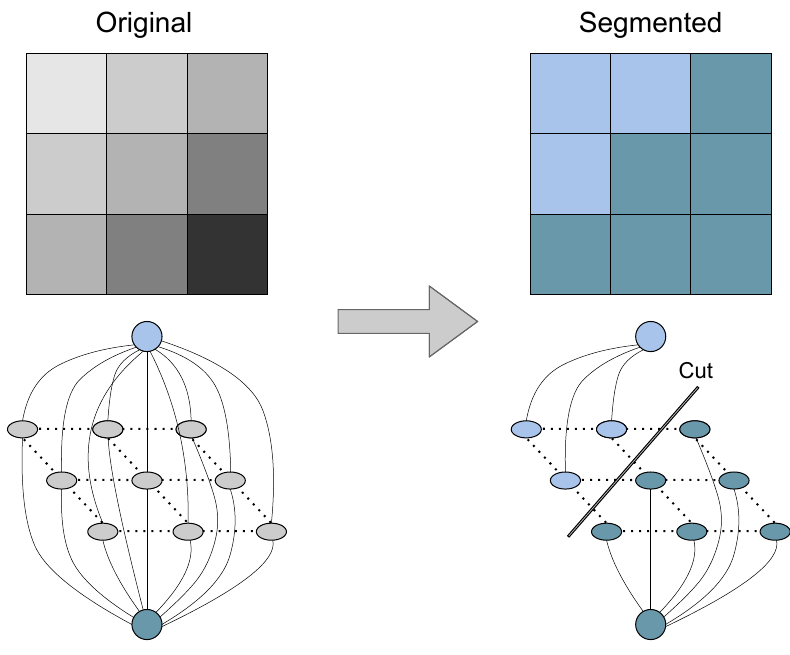
Figure 15. Graph Cut segmentation